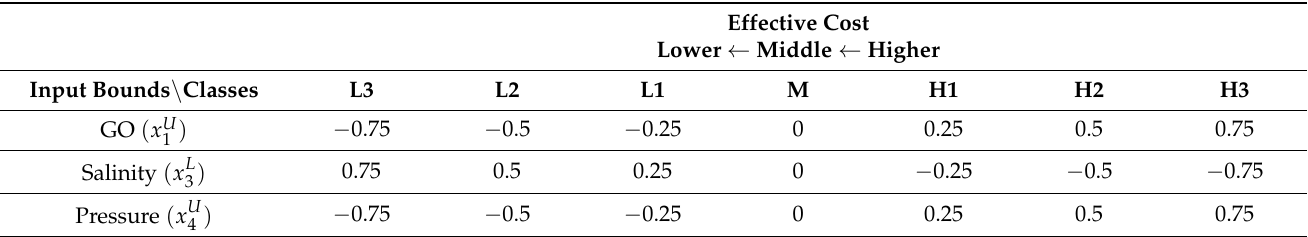
Table 7. Rubric for effective cost and input boundary mapping.